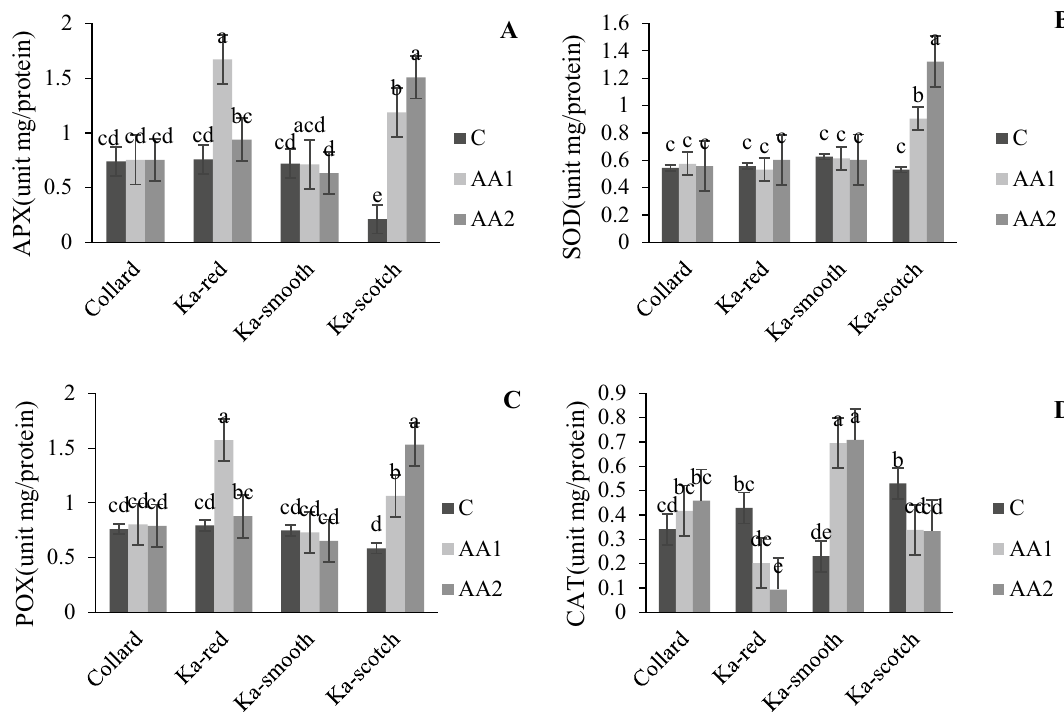
Figure 3. Interaction effect of cabbage cultivar and AA application on antioxidant enzyme activities. APX ascorbate peroxidase, SOD superoxide dismutase, POX peroxidase, CAT catalase, C control treatment, AA1 150 mg/L of amino acid, AA2 150 and 300 mg/L of amino acid.